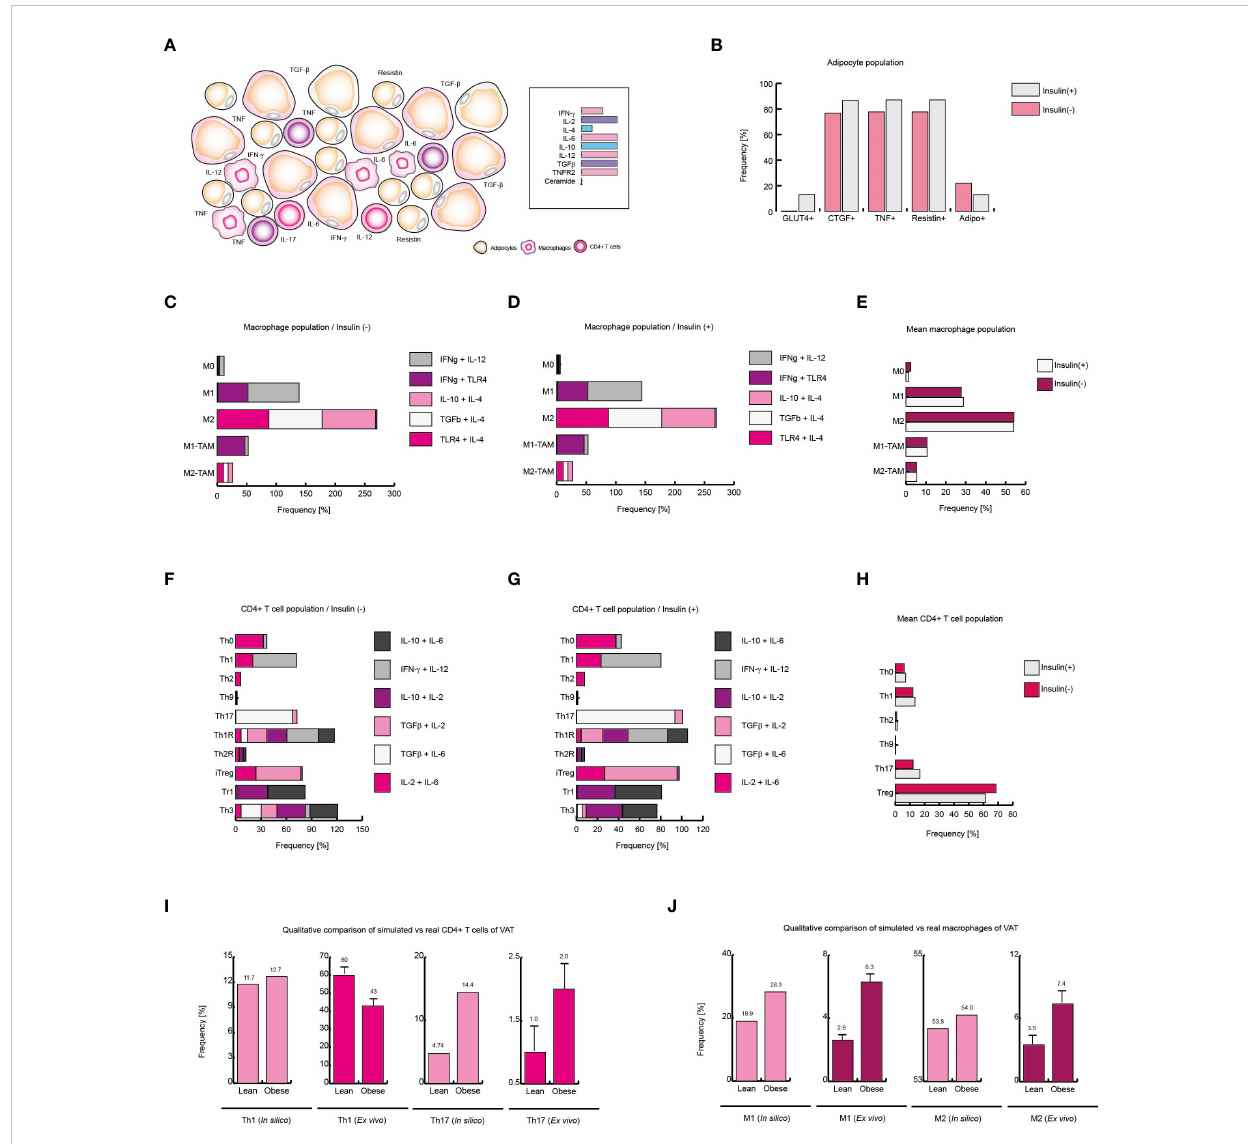
FIGURE 6 Obesity increases local Th17 immunity in VAT. (A) Schematic representation of the simulated conditions within VAT of obese patients. (B) Phenotype distribution of adipocytes with and without insulin. (C) Phenotype distribution of macrophages in absence of insulin, and (D) in presence of insulin. (E) Mean behavior of macrophage phenotype distribution. (F) Distribution of CD4+ T cells without insulin, (G) and with insulin. (H) Mean distribution of CD4+ T lymphocytes phenotypes. (I) Simulated Th1 and Th17 populations versus real frequencies of such phenotypes. (J) Simulated M1 and M2 populations versus their ex vivo frequencies. The values presented for panels (I, J) was adapted from (35) and (9) respectively. Collectively, these data suggest that insulin enhances Th17 immunity in obese